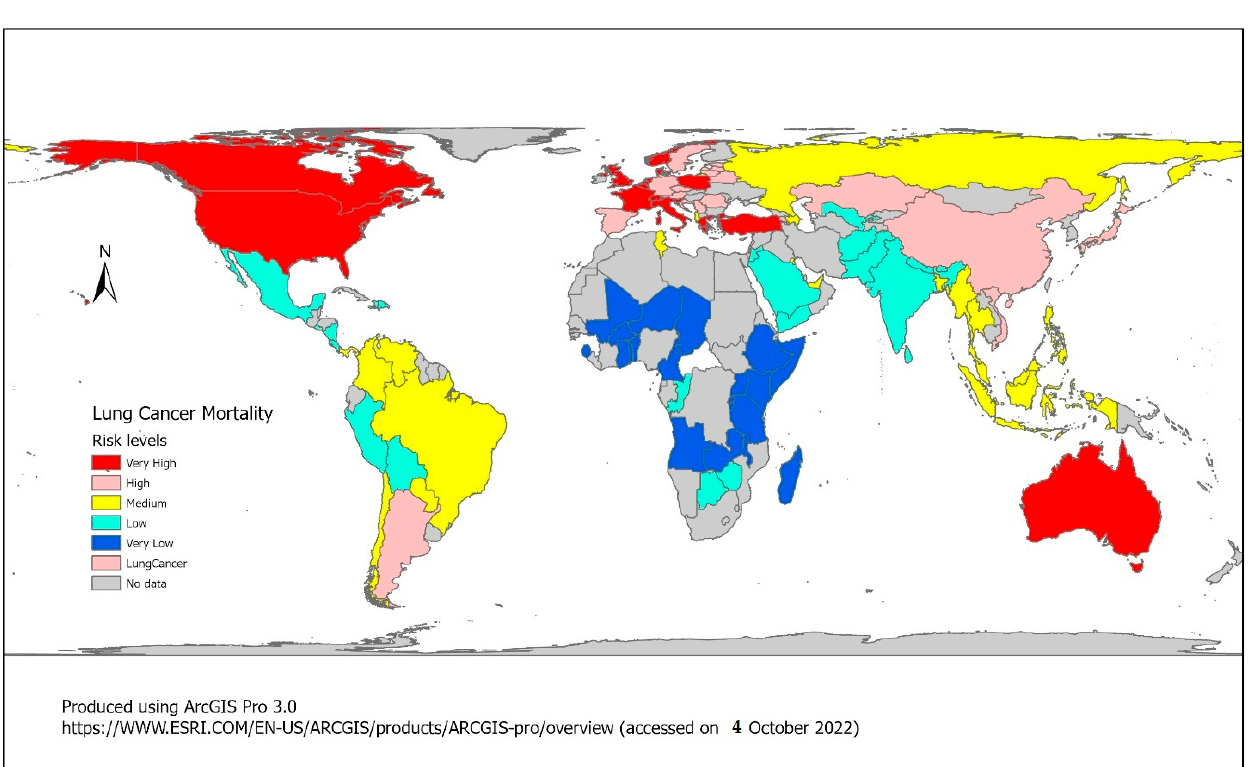
Figure 1. Risk levels of LCM in 100 countries from 2006 to 2016.